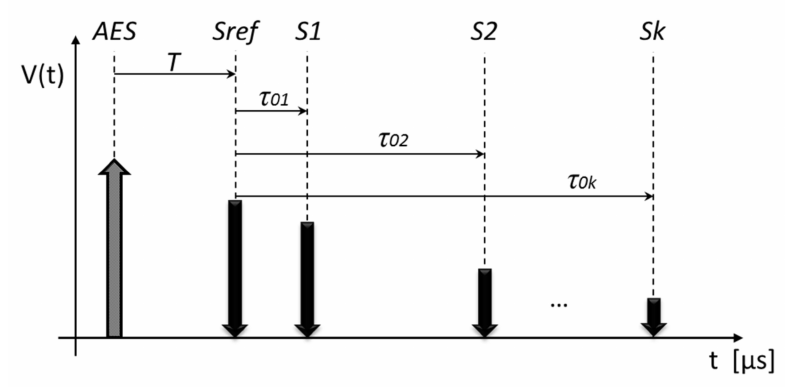
Figure 6. Schematic of time differences with unknown time reference